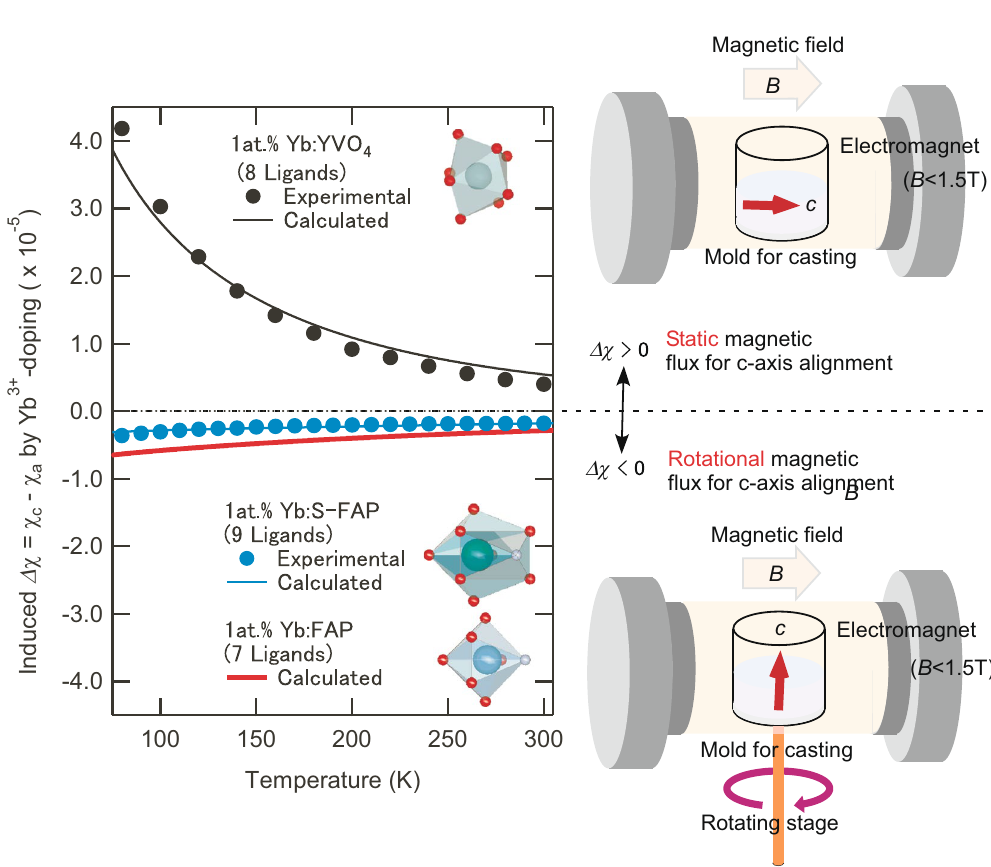
Figure 2. Calculated and experimental crystalline magnetic anisotropy Δχ induced by 1 at. % Yb 3 + -doping. If Δχ > 0, the orientation control of the c -axis in crystalline microparticles can be processed using a static magnetic field. Conversely, if Δχ < 0, orientation control requires a rotating magnetic field. A relative rotating magnetic field can be formed by rotating a slip-casting mold under a static magnetic